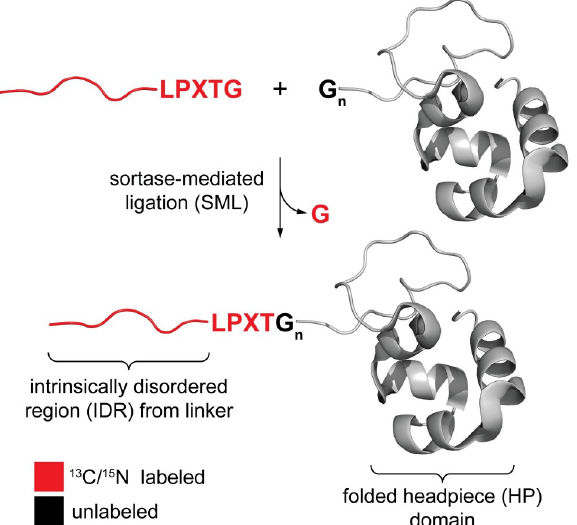
Fig 1. Segmental isotopic labeling via Sortase-Mediated Ligation (SML). Strategy for segmental isotopic labeling of villin 4 utilizing SML between the disordered linker and folded headpiece. LPXTG represents the requisite sortase recognition